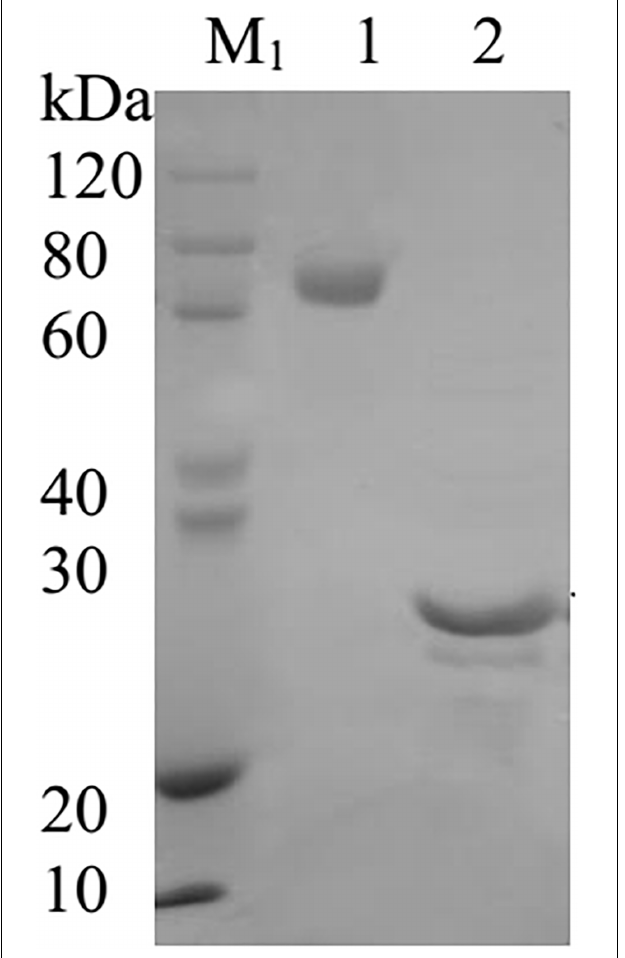
FIGURE 1 | The image of the sodium dodecyl sulfate-polyacrylamide gel electrophoresis of AtFLA11. M 1 , SDS-PAGE Protein Marker; Lane 1, BSA protein; Lane 2, AtFLA11